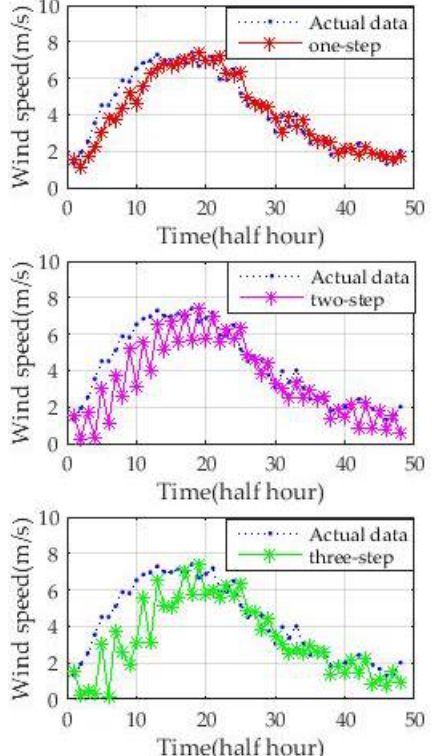
Figure 7. Forecasting results on 20 February 2004.